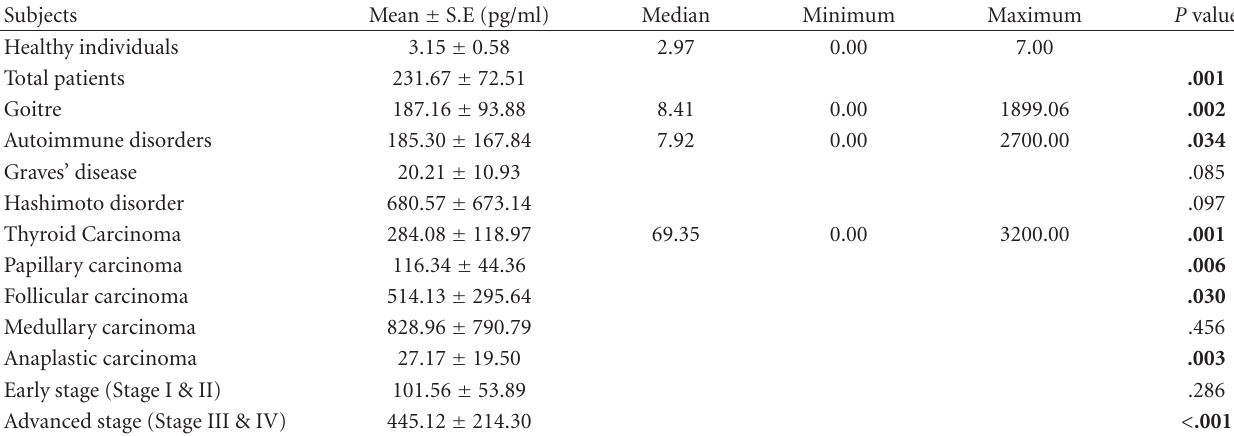
Table 3: Significance of IL-8 levels in patients with thyroid diseases as compared to healthy